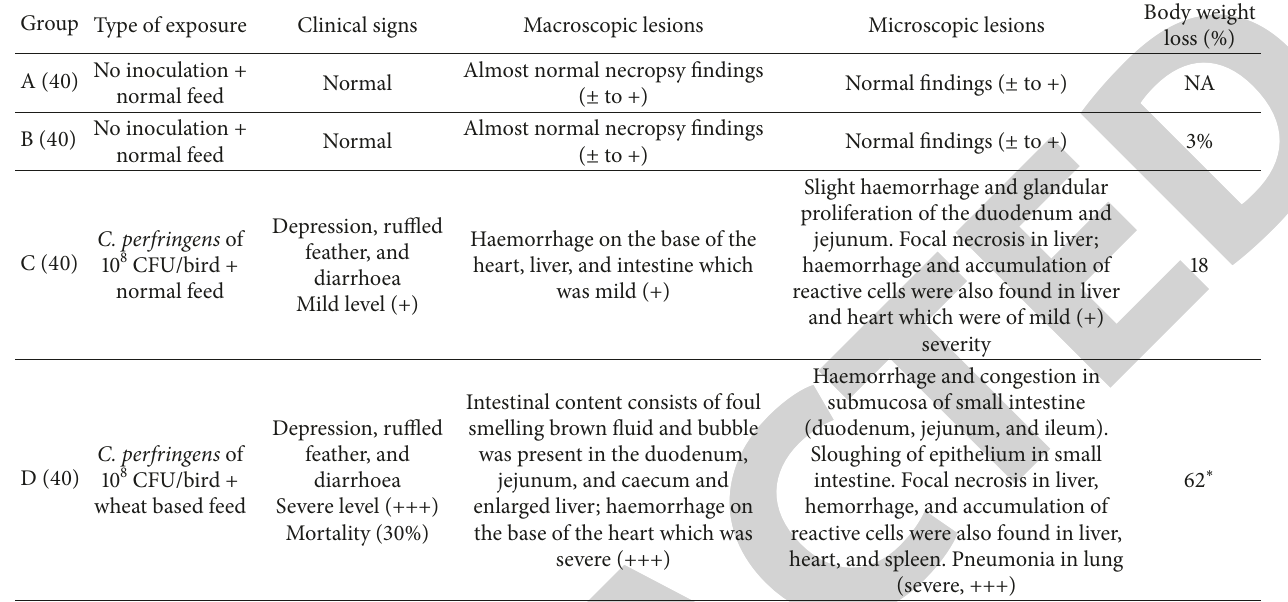
Table 2: Clinical signs, gross, and histopathology lesions in turkeys experimentally infected with C. perfringens. Group Type of exposure Clinical signs Macroscopic